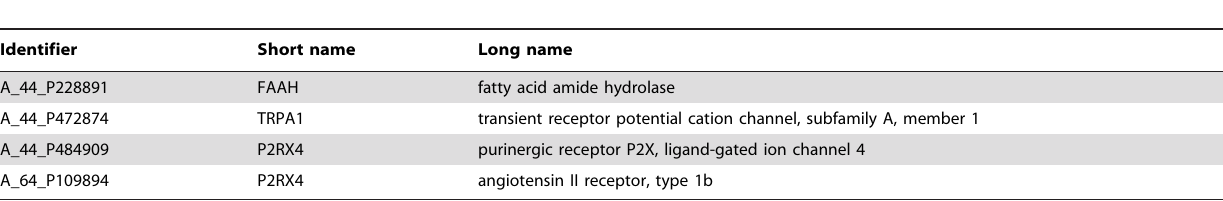
Table 5. Downregulated genes specifically involved in pain transmission in NMS rats in comparison with normal